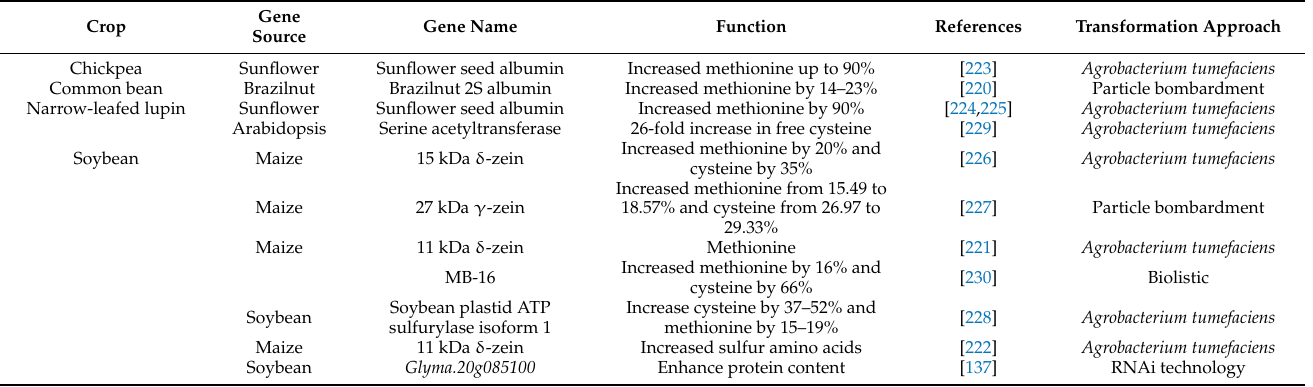
Table 5. Selected list of grain legumes with improved seed protein content using a genetic engineering